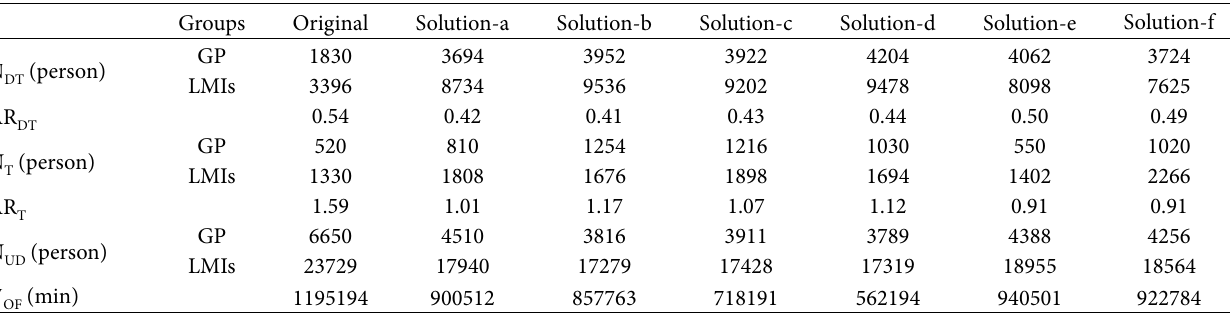
Table 3: Results of original and ACA–GA transit route networks.